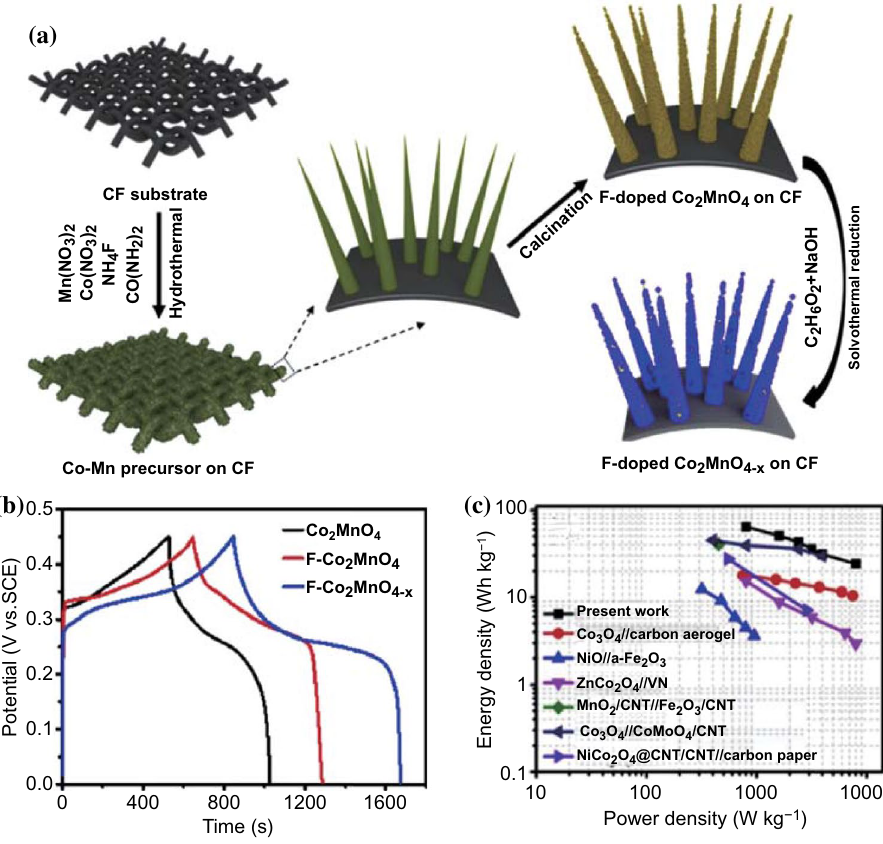
Fig. 14 a Schematic of the synthesis of F-Co 2 MnO 4−x nanowires on CF substrate. b GCD curves of Co 2 MnO 4 , F-Co 2 MnO 4 , and F-Co 2 MnO 4− x electrodes at 1 A g −1 . c Ragone plot of F-Co 2 MnO 4− x /CF//Fe 2 O 3 /CF device. Adapted with permission from Ref. [125] Copyright 2019